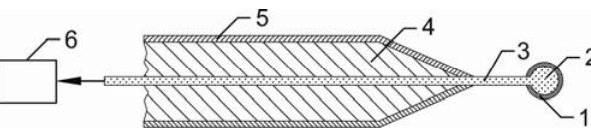
Figure 1. Schematic of the fiber optic catalytic probe (FOCP): 1—catalyst coating; 2—fiber tip; 3—optical fiber; 4—two-component silicone rubber; 5—aluminum housing; 6—optoelectronic detection